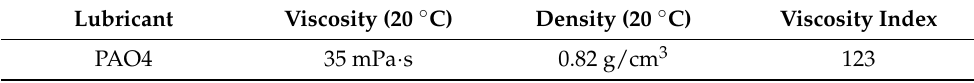
Table 3. Parameters of PAO4.